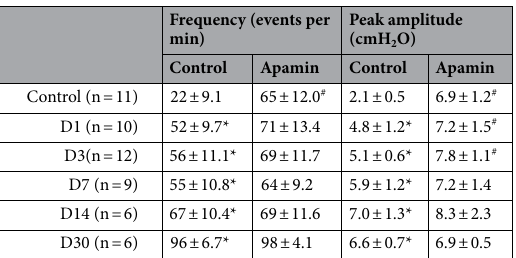
Table 1. Summarized data of frequency and amplitude before and after apamin. *P < 0.05 denotes comparison between control and each period after SCI. # P < 0.05 denotes comparison of effects of apamin at each period.